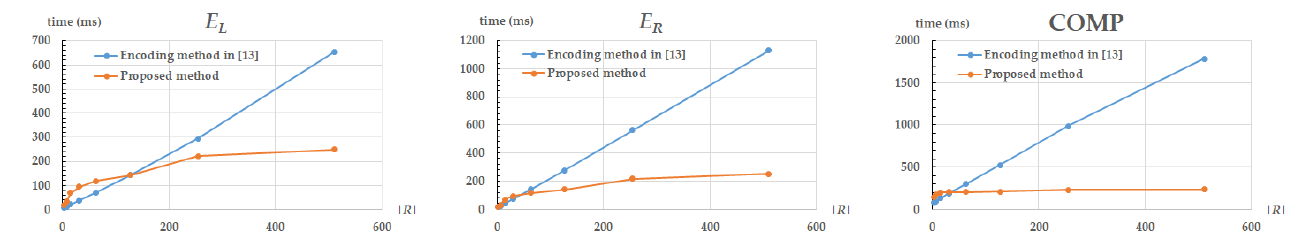
Figure 11. Comparison of the computation times of the E L , E R and COMP on the smart